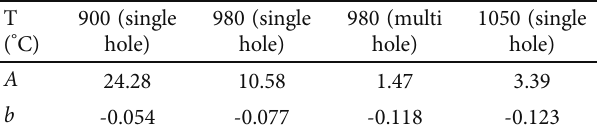
Table 3: Parameters of critical distance equation.